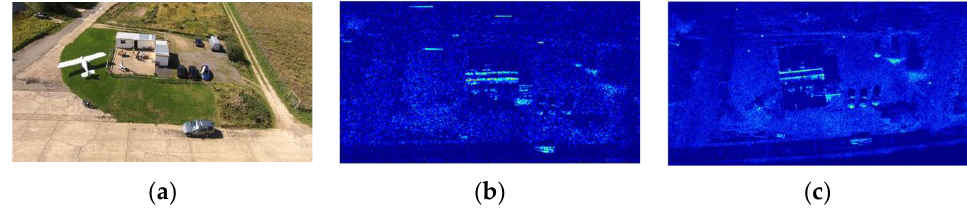
Figure 13. Examples of autofocusing algorithm (after [43]): ( a ) Optical image, ( b ) image without movement compensation, and ( c ) after movement compensation.